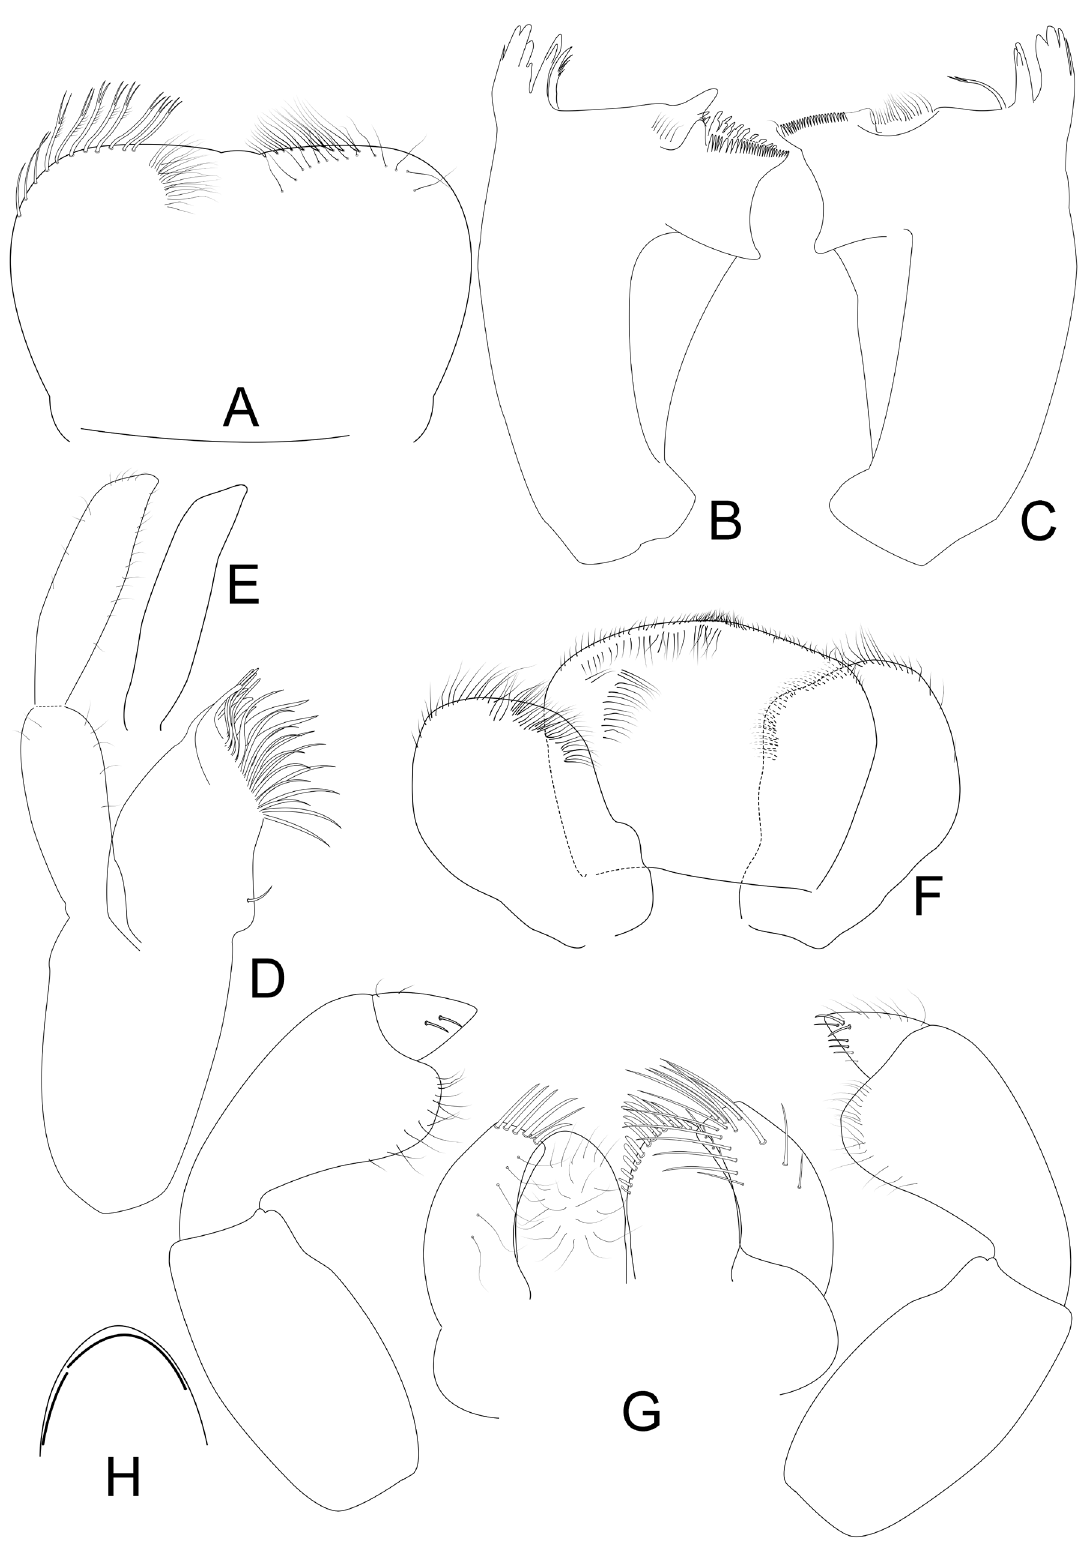
Fig. 4. Rivudiva amazona sp. nov., holotype (INPA). A . Labrum (left v.v., right d.v.). B . Left mandible. C . Right mandible. D . Left maxilla. E . Variation of maxillar palp segment II (right maxilla). F . Hypopharynx. G . Labium (left v.v., right d.v.). H . Shape of distal rows of setae of glossa. Not to